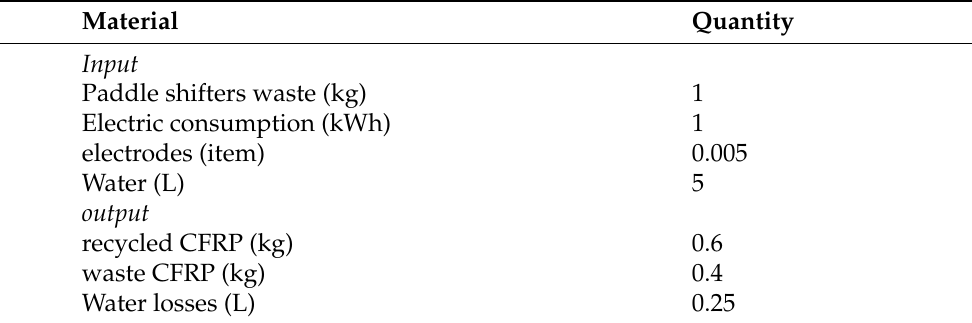
Table 7. Inventory data for the mechanical recycling of paddle shifters. The consumption of the electrodes were allocated to 1 kg of CFRP waste on the mass basis. The data are valid both for CFRP-ff and CFRP-bio.